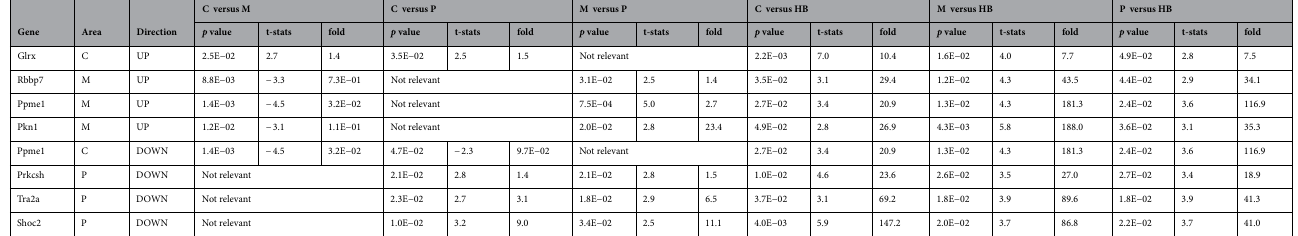
many biosynthesis-related cellular processes are up-regulated in 4T1 (Table S5), which is consistent with the tumor’s need for enhanced replication rates 55 . These findings are also supported by many upregulated cellular functions (Table S6) and cellular components (Table S7). These data show that in vivo e-biopsy extraction of proteins yields statistically significant and biologically different profiles when comparing various locations in 4T1 tumors to healthy breast tissue in mice.